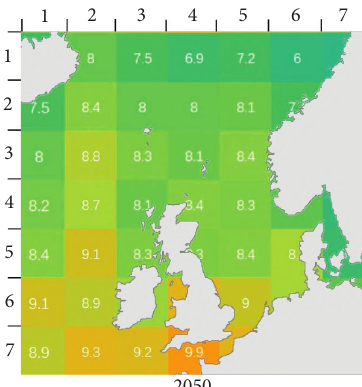
Figure 16: The predicted annual average sea temperature of the study area in 2050.